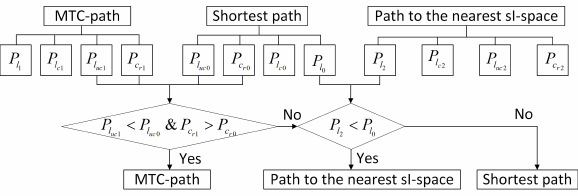
Table 1. Original information of the navigation graph.